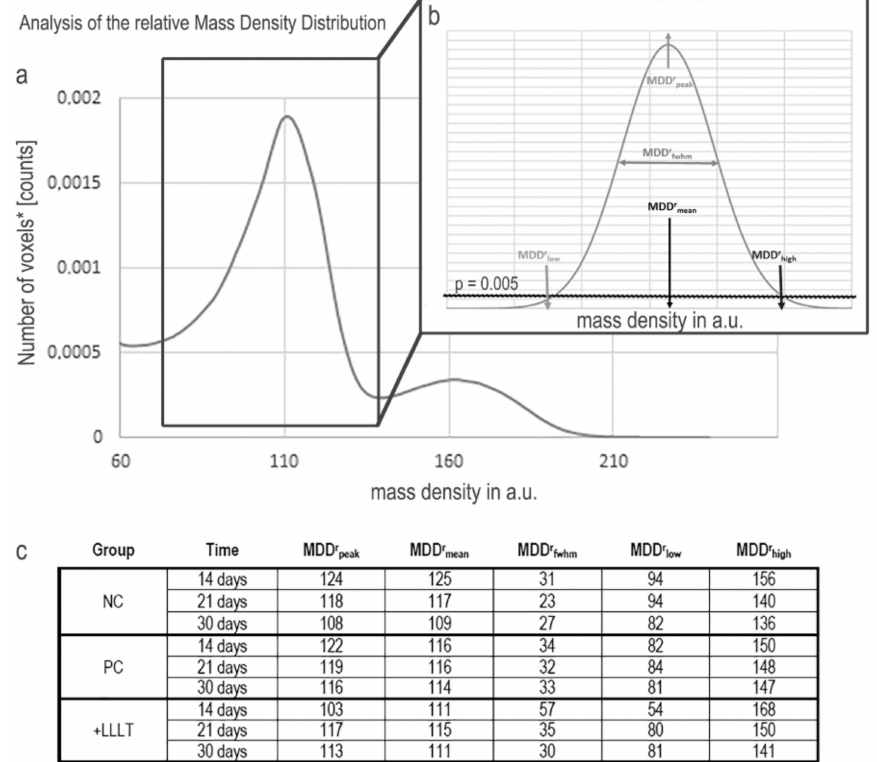
Figure 3. Study of the relative mass density distribution (MDD r ). (a) Portion of the histogram of a sampling biopsy: the peak on the left refers to the overall mineralized bone, the peak on the right refers to the biomaterial (xenograft) used to fill the defect; (b) study of the mineralized bone: the parameters investigated with the Roschger approach [38] are indicated. The threshold of p = 0.005 has been selected, as a good compromise to maintain a good sensitivity and minimize at the same time potential artifacts due to partial volume e ff ects in the evaluation of MDD r low ; (c) parameters that derive from the profile fitting are